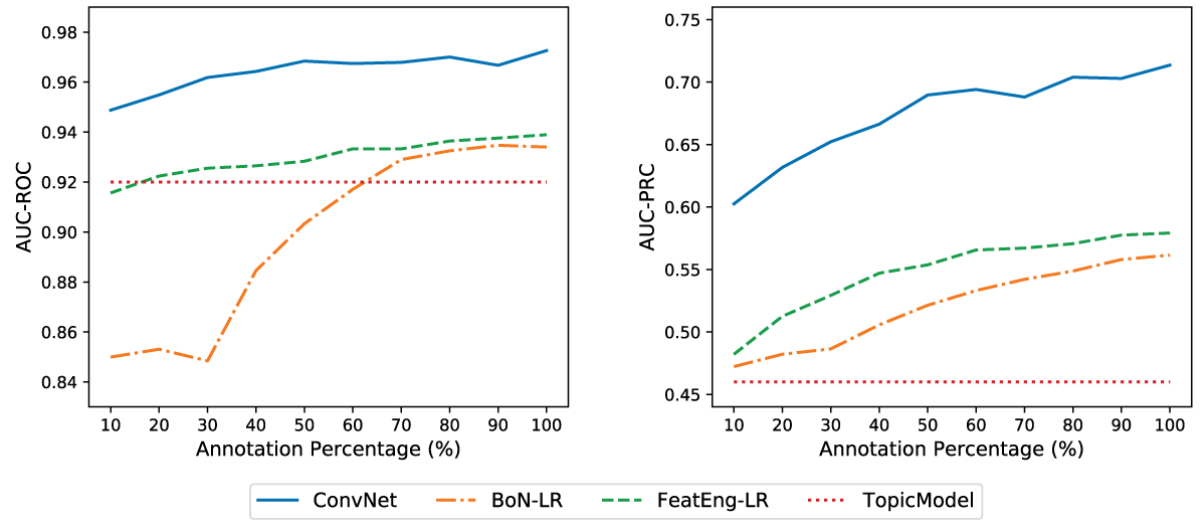
Figure 4 highlights the distributions of the classification scores (predicted probability of the label acute LBP ) derived by several supervised models (trained with manual annotations) and TopicModel. ConvNet shows a clear separation between acute LBP notes and the rest of the dataset. In particular, all acute LBP notes had scores greater than 0.2, with 81.6% (727/891)